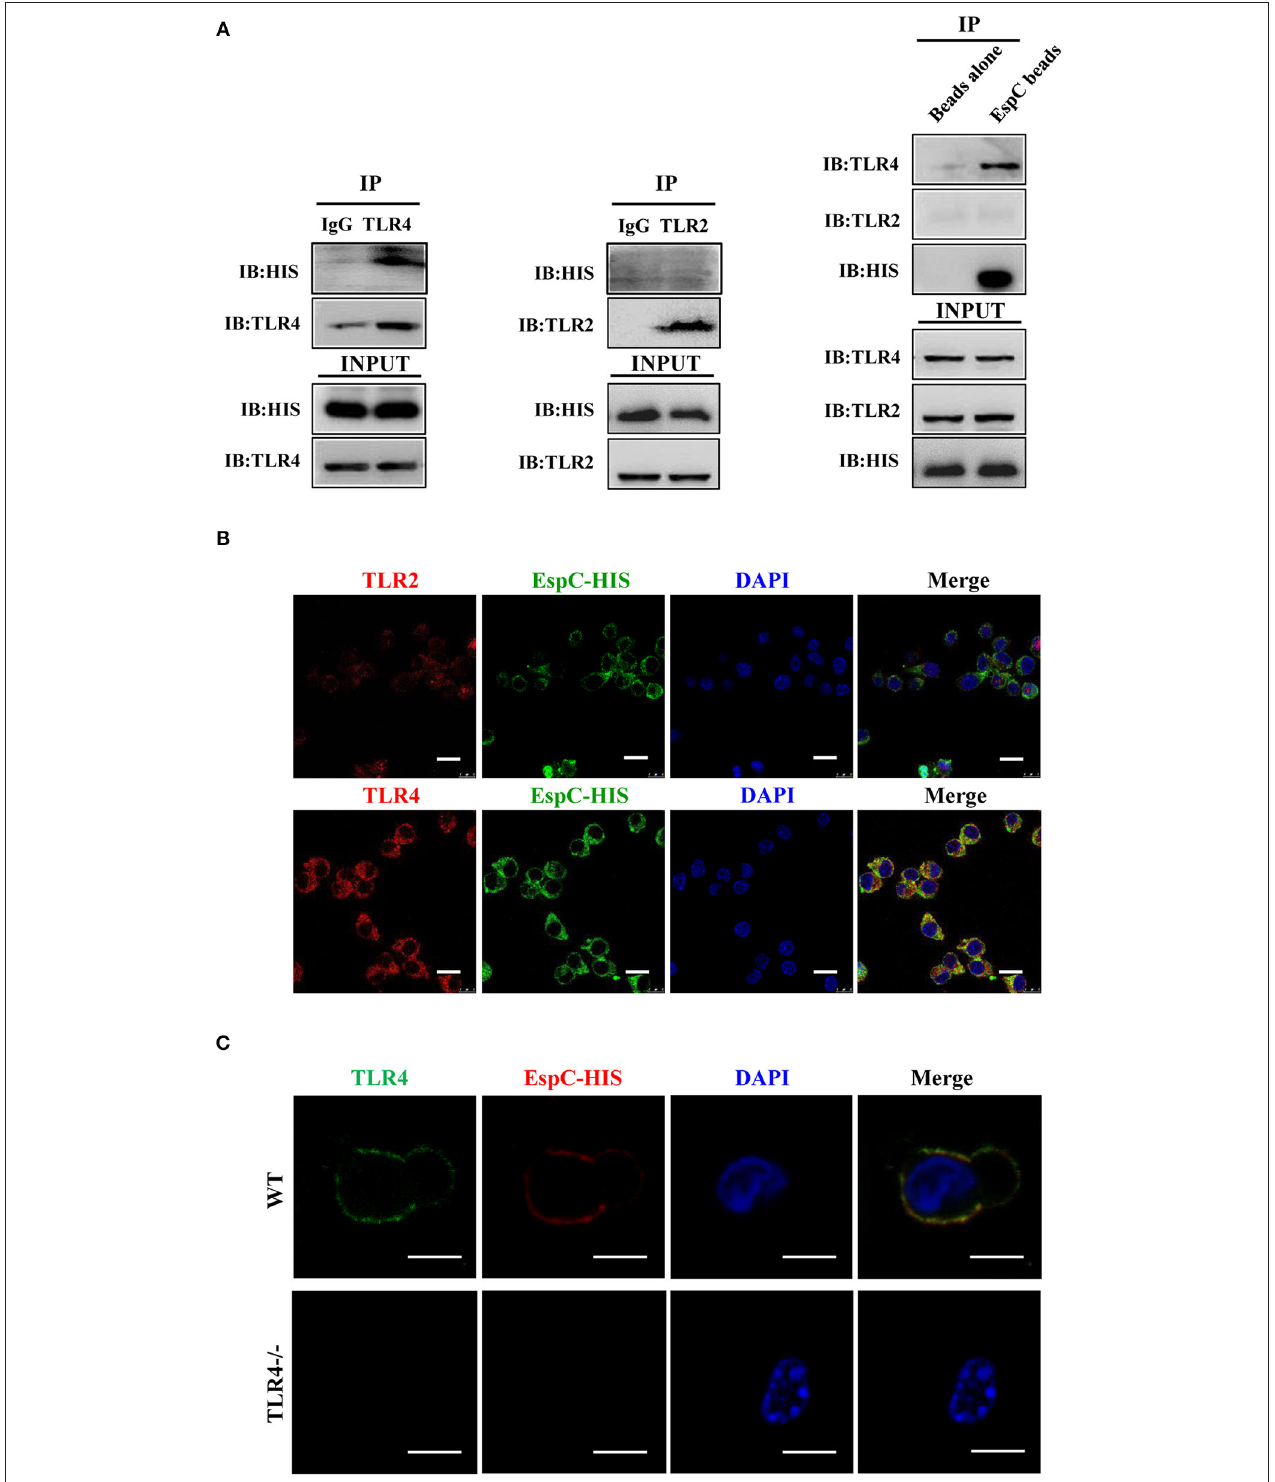
FIGURE 2 | EspC bound to TLR4 but not TLR2. (A) Cell lysates were incubated with EspC (5 µ g/mL) for 12h and were then immunoprecipitated with anti-mouse IgG, anti-TLR2, or anti-TLR4 antibodies. The proteins were then visualized by western blotting with anti-HIS, anti-TLR2, or anti-TLR4 monoclonal antibodies. Total cell lysates were used as input control. Alternatively, cell lysates were incubated with EspC immobilized on Ni-NTA beads, and bead-bound proteins were loaded on gels